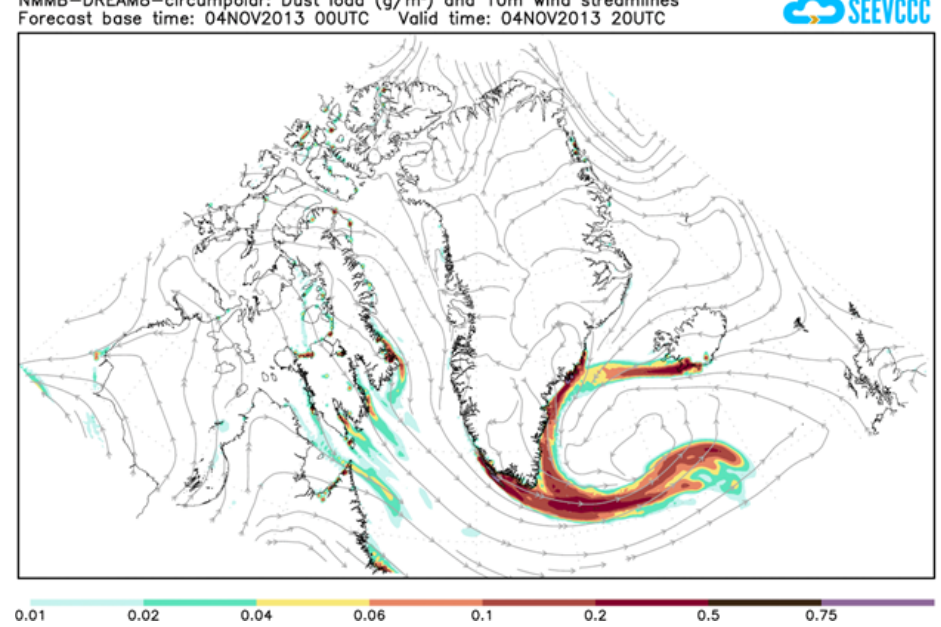
Figure 8. DREAM model-predicted dust load for 4 November 2013 (supplementary animation available through a link in the Supplement).